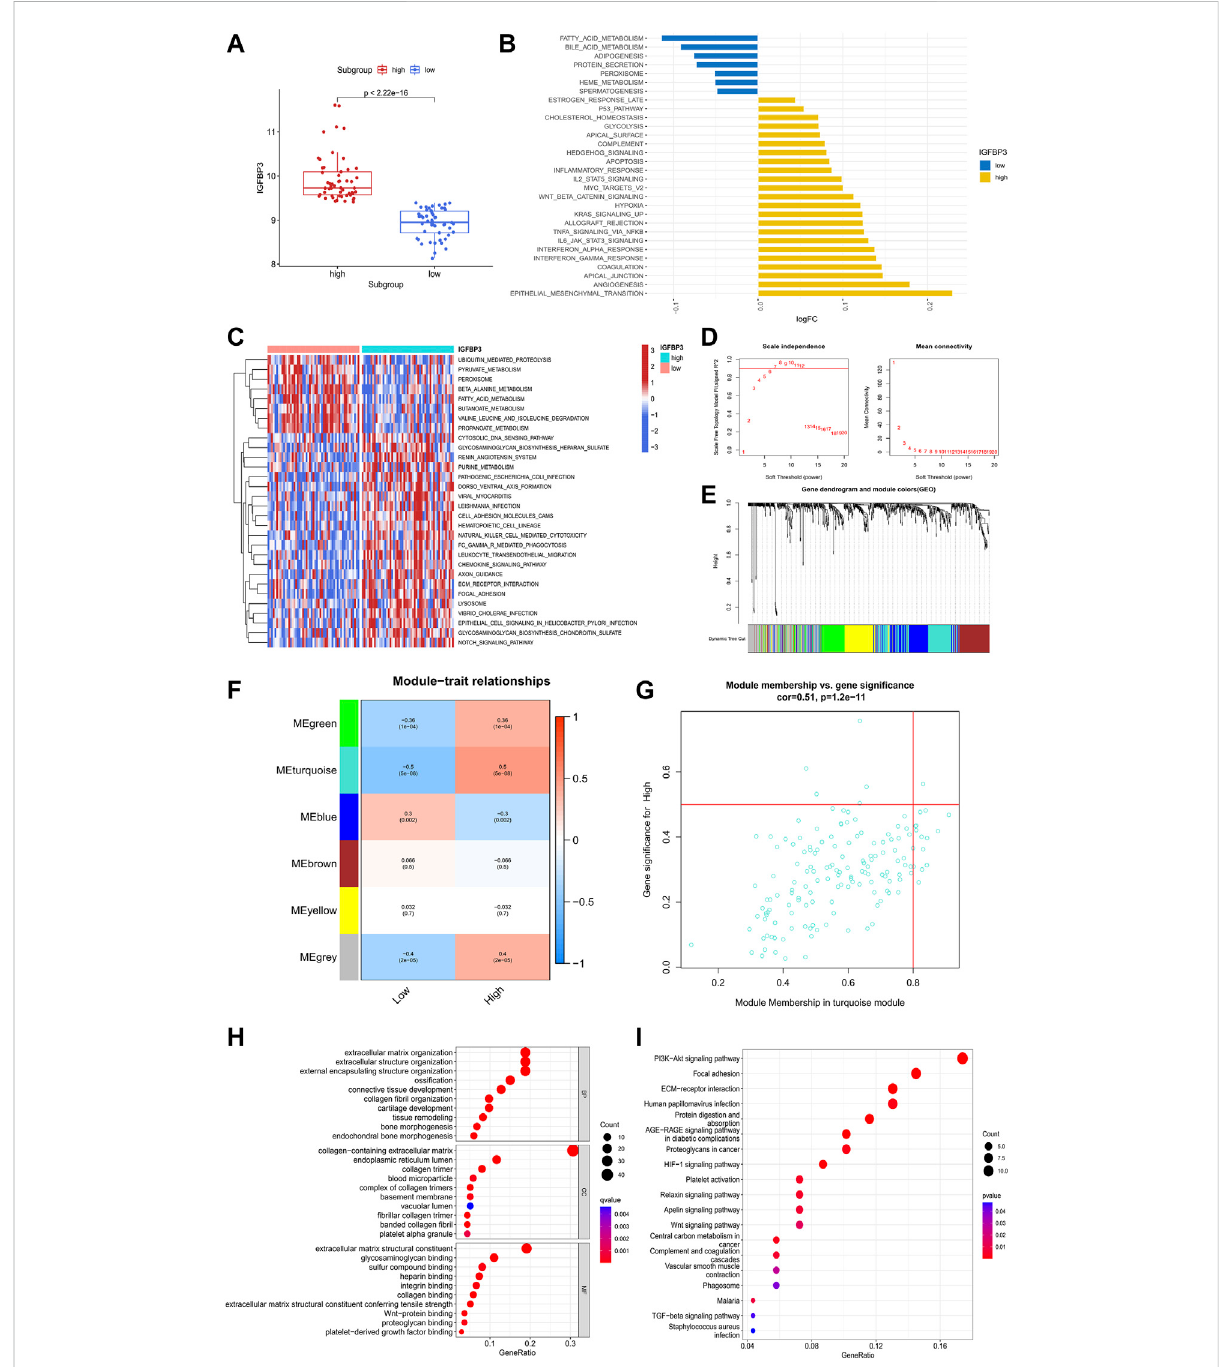
FIGURE 4 Biological enrichment analysis of the two m6A subgroups based on IGFBP3 expression. (A) Difference in the expression of IGFBP3 between subgroups (Wilcox rank sum test). (B) The top 30 different HALLMARKS pathways between distinct m6A subgroups. (C) The top 30 different Kyoto EncyclopediaofGenesandGenomespathwaysbetween distinctm6Asubgroups. (D) Theprocessofweighted geneco-expressionnetwork analysis (WGCNA). Identi fi cation of the soft-thresholding power for the optimal scale-free topology fi t index (left) and mean connectivity (right). The optimal soft threshold power was six. (E) The process of WGCNA. The dendrogram represented the gene clustering, and the color row beneath indicated the six modules identi fi ed after dynamic tree cut and mergence of similar modules. (F) Module-trait relationships demonstrating correlation between the modules identi fi ed through WGCNA and IGFBP3 subgroups using spearman analysis. (G) A scatterplot of gene signi fi cance (GS) vs. module membership (MM) in turquoise module. (H) Gene Ontology analysis of turquoise module illustrated by bubble plot. (I) Kyoto Encyclopedia of Genes and Genomes analysis of turquoise module illustrated by bubble